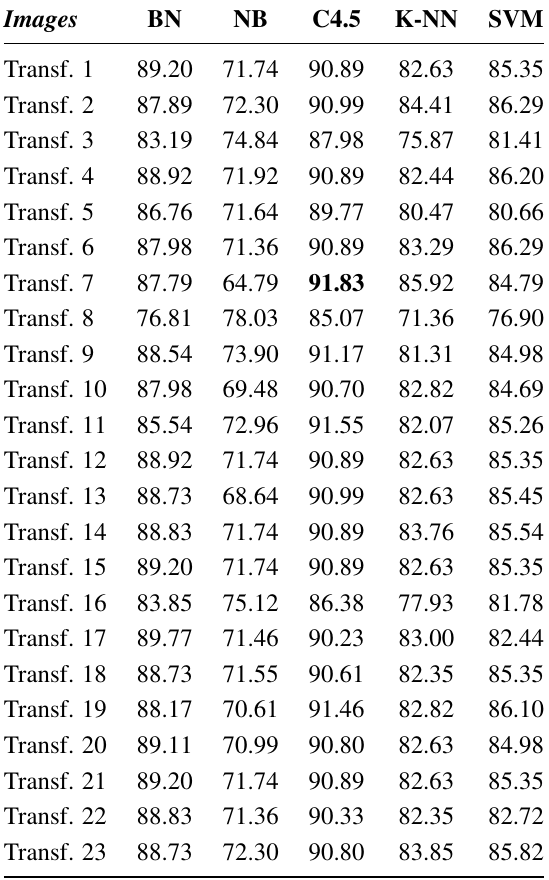
Table 3. IK4-TEKNIKER intensity images: 10-fold cross-validation accuracy percentage obtained for each classifier using each of the proposed